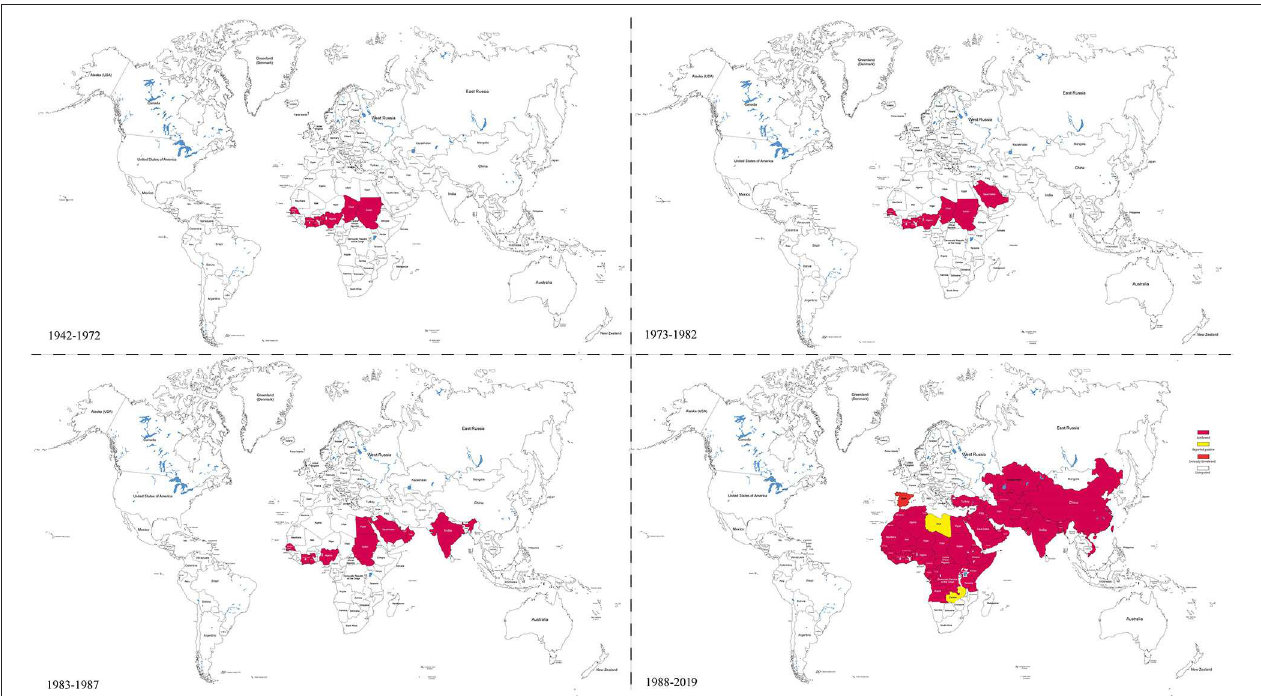
FIGURE 1 | Global distribution of PPRV at different time periods. This figure is drawn according to the relevant reports of PPR and the Table 1 references by Illustrator CS6 software. It shows that the PPRV spread from west to east and the infection is rapidly